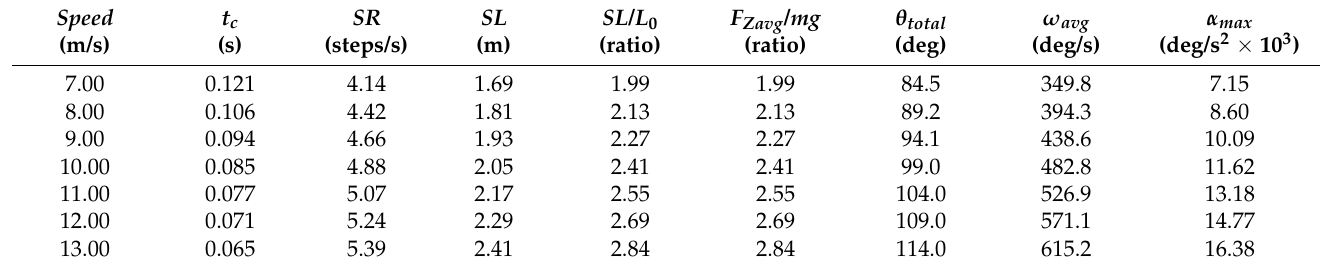
Table 1. Calculated values across a range of speeds for a hypothetical athlete with L 0 = 0.85 m.